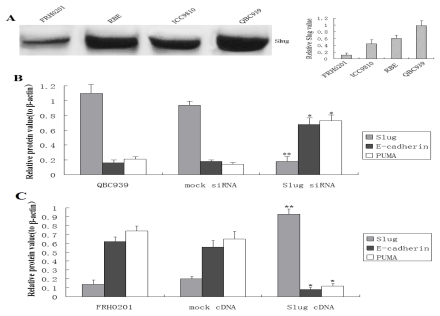
Slug regulation-induced processing of Slug and PUMA. (A) The protein fractions of Slug in QBC939, RBE, ICC-9810, and FRH 0201 cells were subjected to Western blot analysis. FRH 0201 exhibited the lowest expression level of Slug and QBC939 exhibited the highest expression level of Slug. (B) The protein fractions of Slug, E-cadherin, and PUMA in QBC939 cells after transfection with Slug siRNA for 48 h were subjected to Western blot analysis. Slug expression was barely detectable compared with parental cells (**P < 0.01), and a remarkble upregulation of E-cadherin and PUMA protein was shown compared with parental cells (*P < 0.05). (C) The protein fractions of Slug, E-cadherin, and PUMA in the FRH 0201 cell line after transfection with Slug cDNA for 48 h were subjected to Western blot analysis. Remarkable upregulation of Slug protein was shown compared with parental cells (**P < 0.01), and remarkable downregulation of PUMA and E-cadherin proteins was shown compared with parental cells (*P < 0.05).